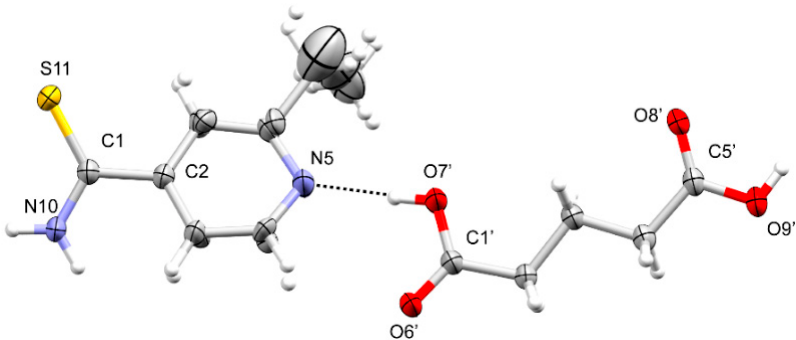
Figure 1. Asymmetric unit of ETN·GLU.